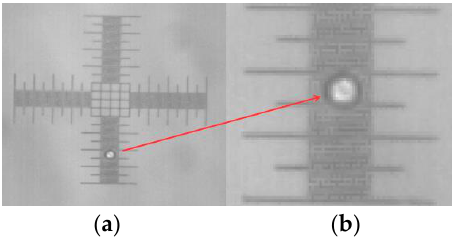
Figure 4. Microbubble generated with a MBB - BP-L-30 micropipette. ( a ) Microbubble over the 1DIV/10 µ m micrometric ruler and ( b ) zoomed version of the microbubble region.